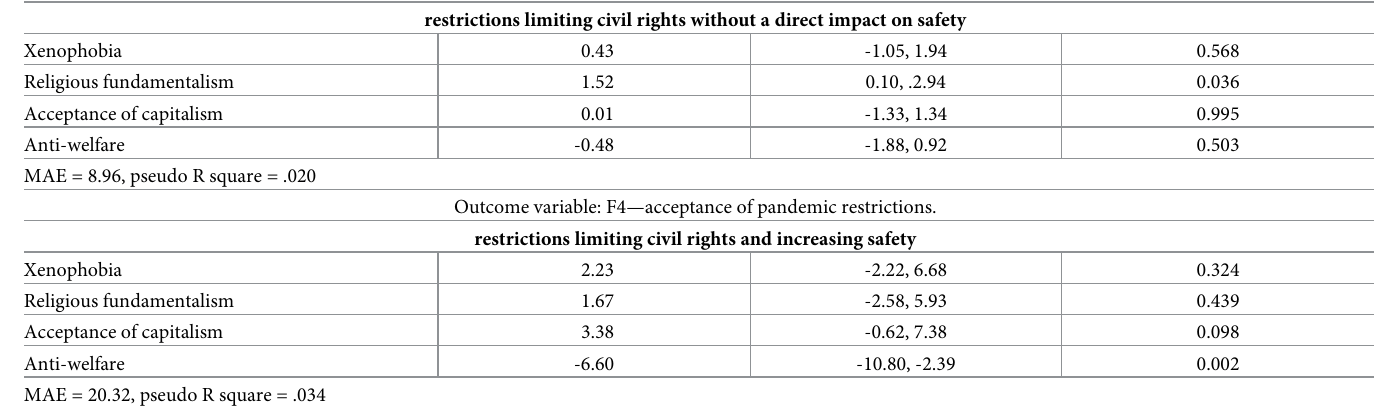
MAE = 18.58, pseudo R square =